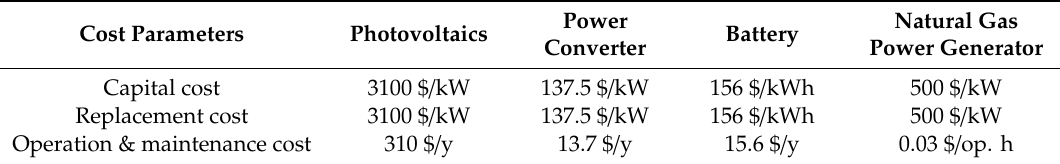
Table 2. Cost details of the most important equipments used in power supply systems [24,29,36,37]. Cost Parameters Photovoltaics